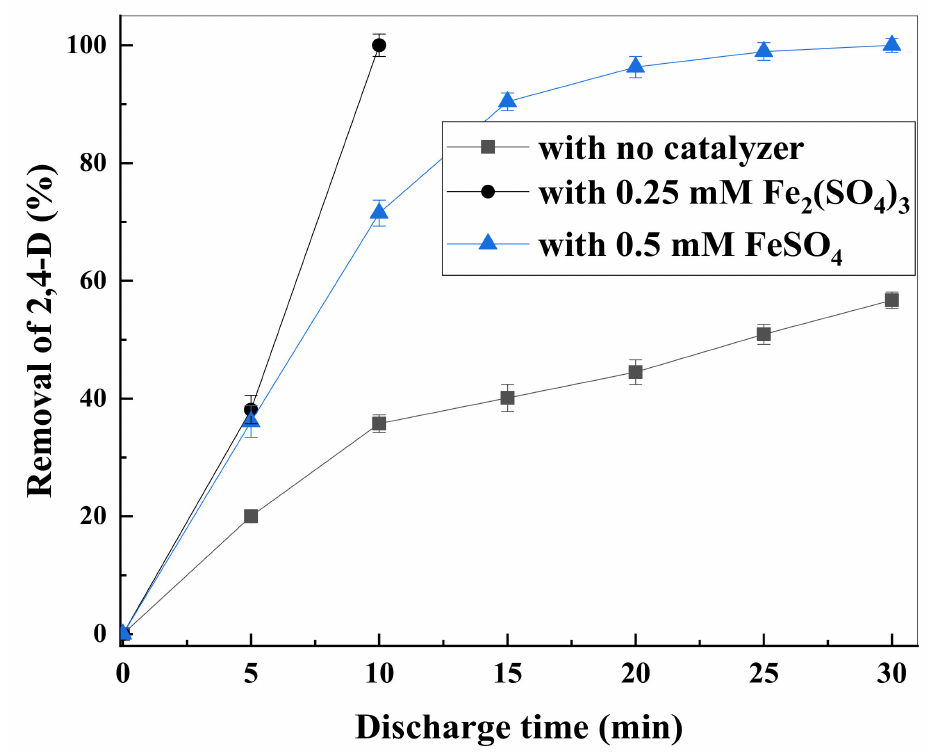
Figure 6. Effect of iron ions on 2,4-D removal in RFD treatment. (Conductivity 1.5 mS/cm, pH 0 2.0, input power 200